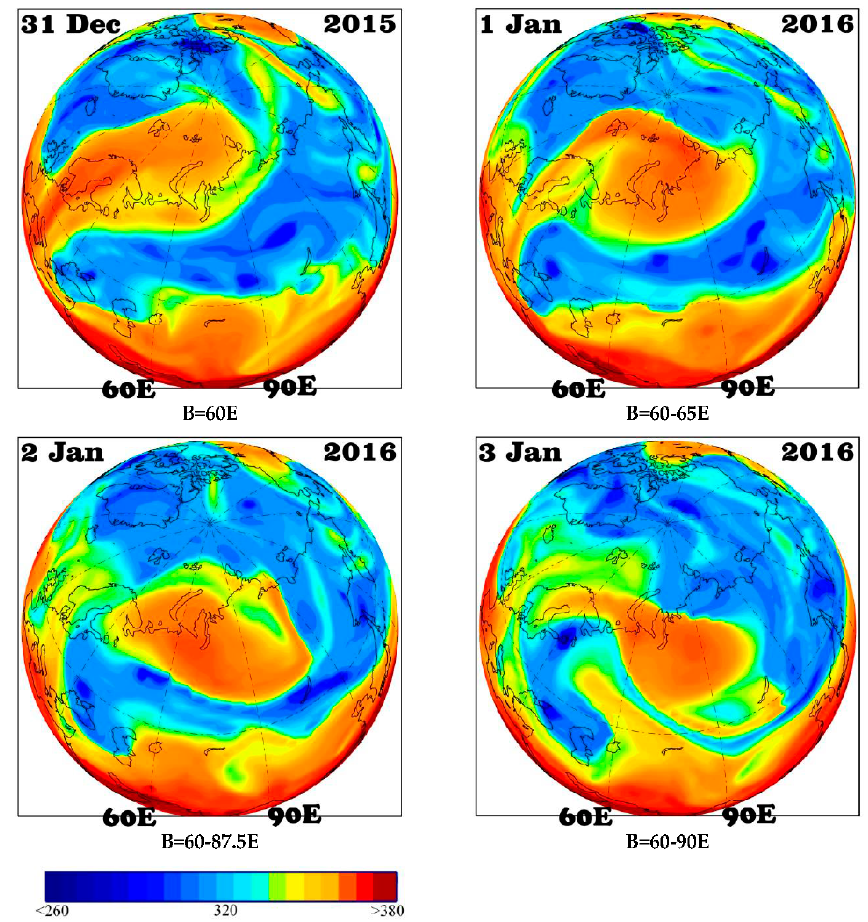
Figure 4. PV2- θ field for the 2015/2016 blocking event, to which a dipole distribution of the surface temperature anomalies corresponds. The longitudes on which the blocking is identified are under each panel.